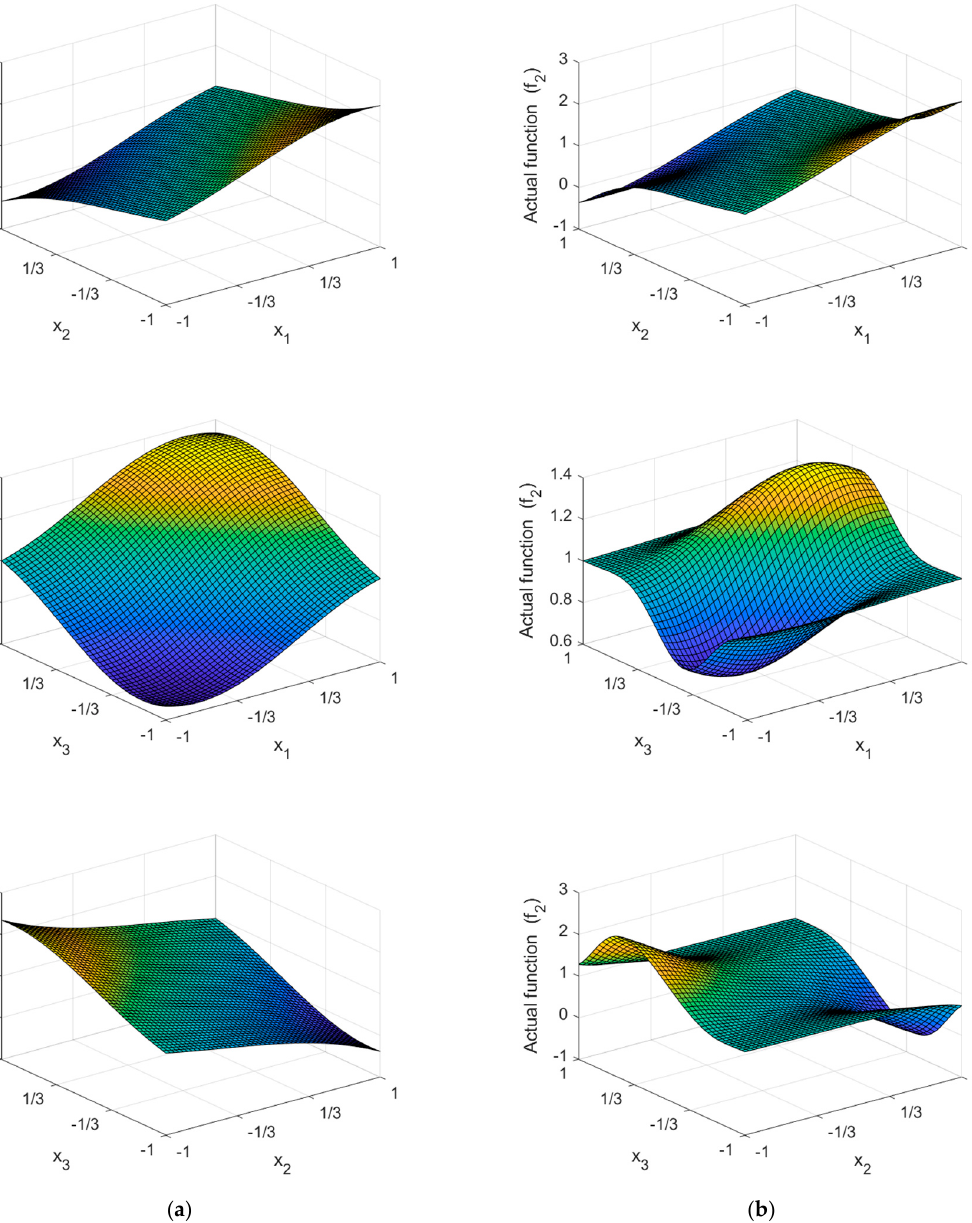
Figure 2. ( a ) Actual values of 𝑓 (cid:2869) function (type 1), where 𝑎 (cid:2868) = 1,𝑎 (cid:2869) = 𝑎 (cid:2870) = 𝑎 (cid:2871) = 0.75 and ( b ) Actual values of 𝑓 (cid:2870) function (type 2), where 𝑎 (cid:2868) = 1,𝑎 (cid:2869) = 1,𝑎 (cid:2870) = 1.5,𝑎 (cid:2871) = 2 Table 3. Values obtained from type 2 function (𝑓 (cid:2870) ) , where a (cid:2868) = 1,a (cid:2869) = 1,a (cid:2870) = 1.5,a (cid:2871) = 2. (Tr = Train, Ts = Test, Vd = Validate) Exp. 𝒇 𝟐 Exp.